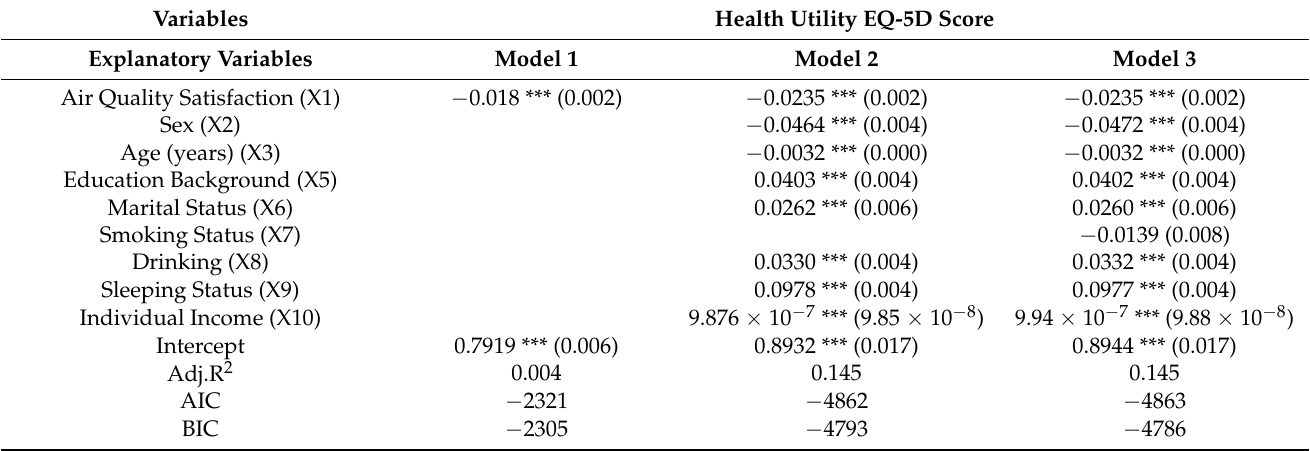
Table 4. Multiple linear regression analysis of factors influencing health utility values ( n = 16,736).